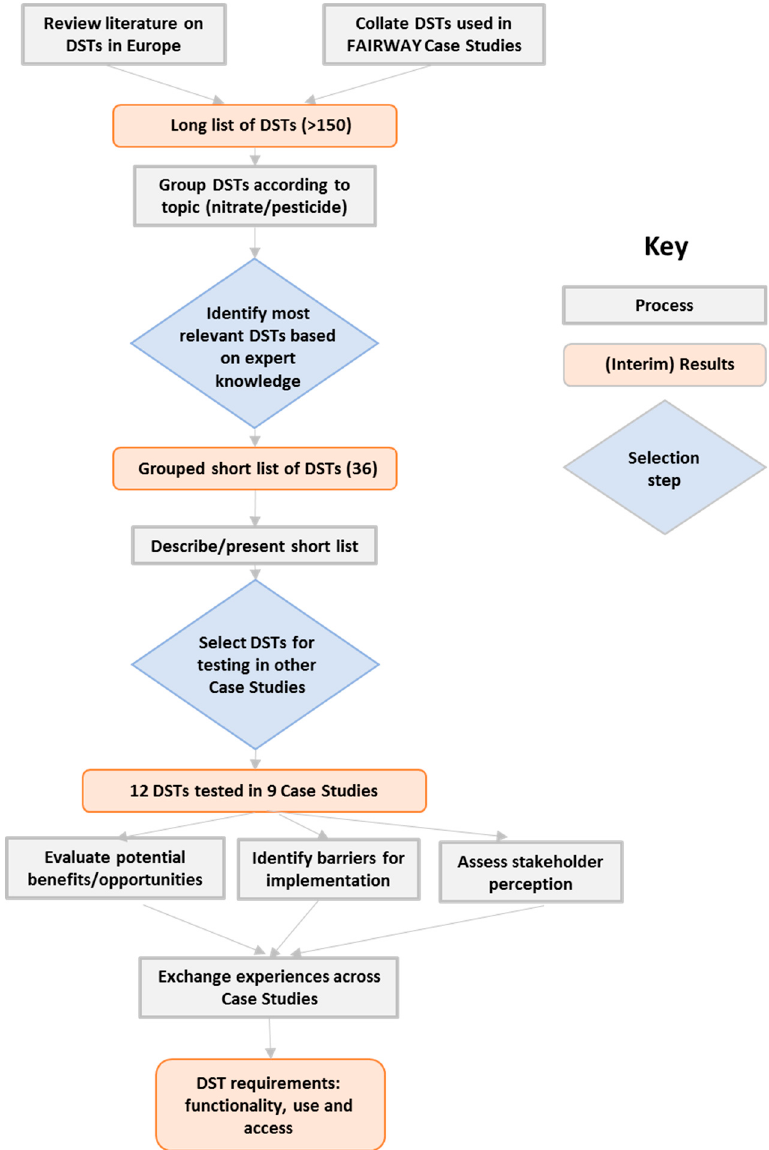
Figure 2. Flowchart showing the stages of the review, selection and testing of DSTs in the FAIRWAY case studies.